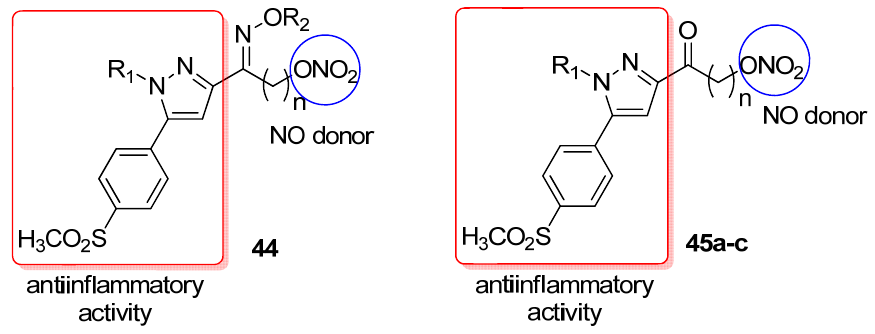
Figure 27. Hybrid pyrazole/NO derivatives ( 44 R R = 4-methoxyphenyl, n = 3; 45b R 1